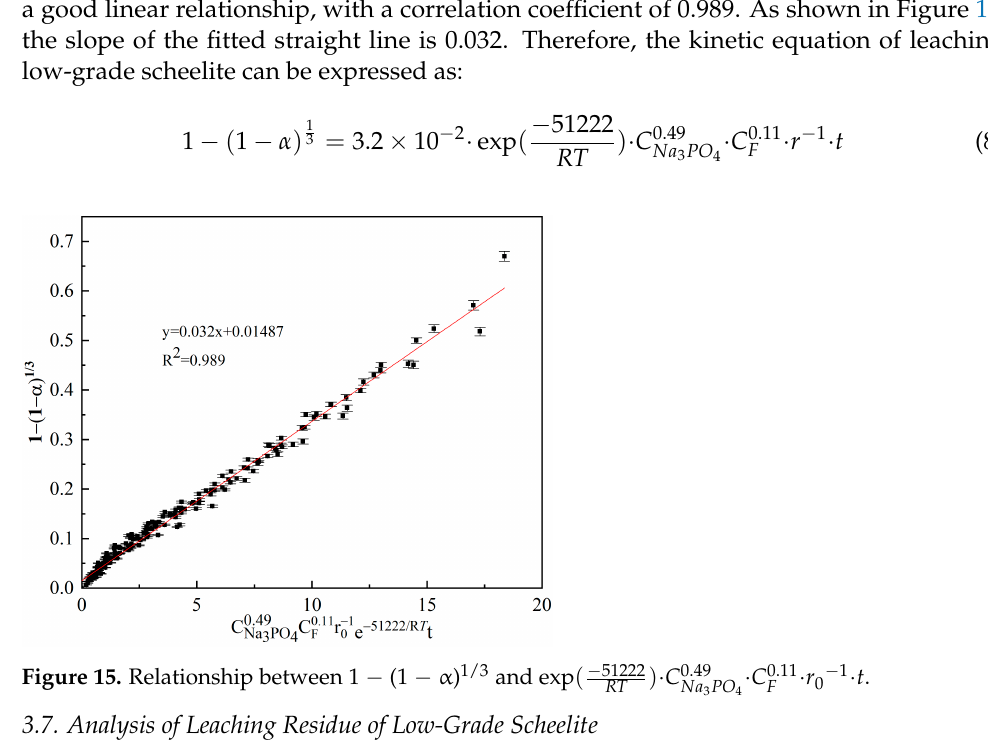
Figure 15. Relationship between 1 − (1 − α ) 1/3 and exp ( − 51222